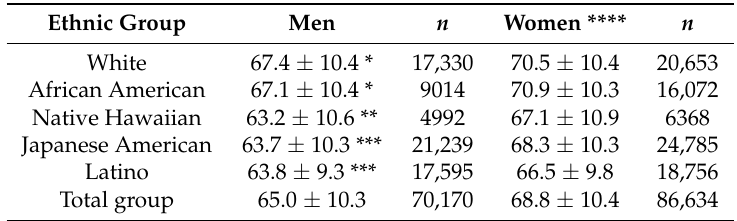
Table A1. Estimated mean and standard deviation of HEI-2015 total scores by ethnic group and sex, the Multiethnic Cohort a